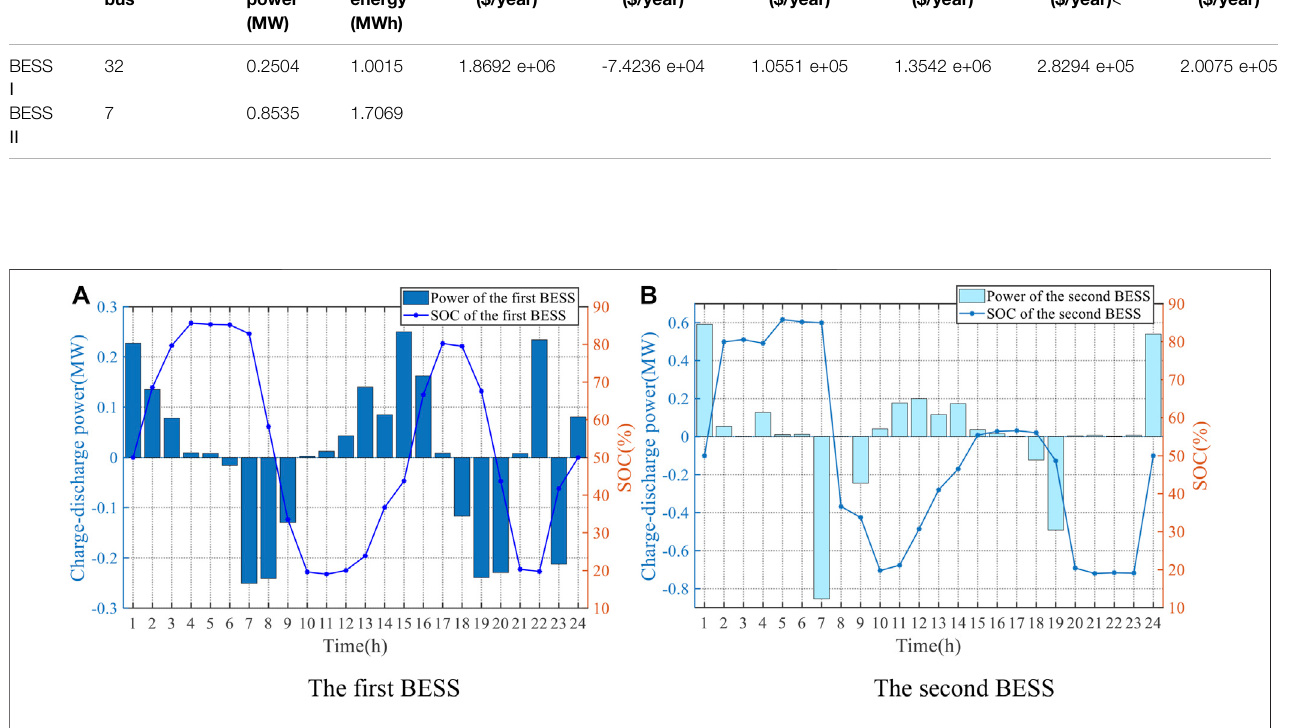
Frontiers in Energy Research |